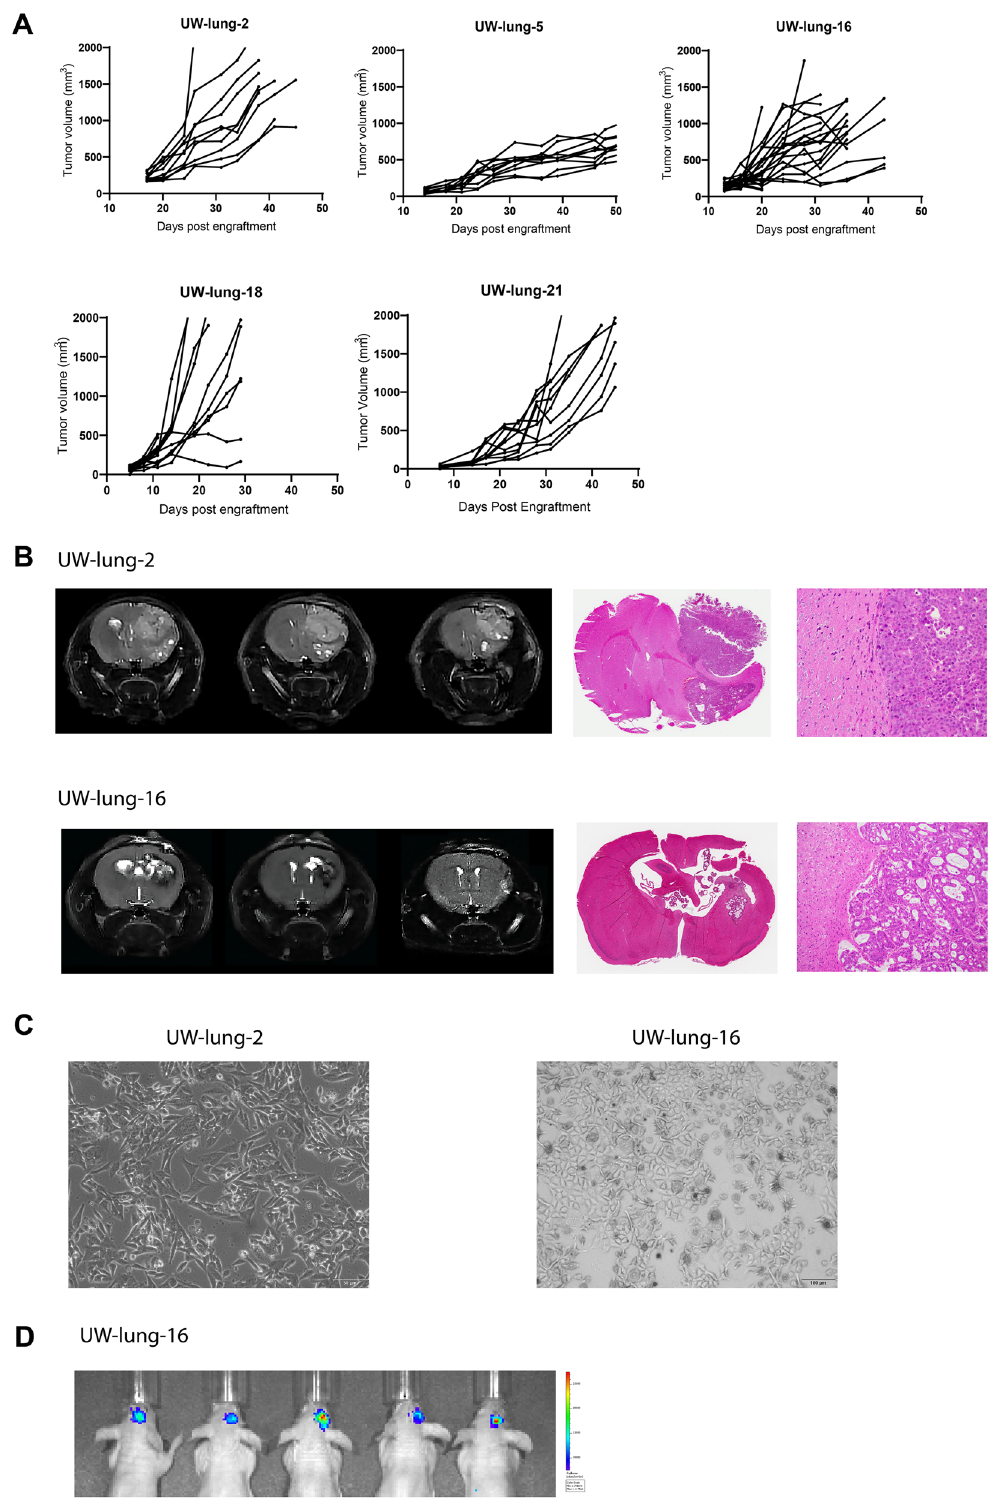
Figure 3. Establishment of subcutaneous flank and orthotopic intracranial patient non-small cell lung cancer (NSCLC) brain metastasis xenografts. ( A ) Subcutaneous flank xenograft growth characteristics of University of Wisconsin (UW)-lung-2, UW-lung-5, UW-lung-16 and UW-lung-18 and UW-lung-21. Tumors were derived directly from patients’ tumors. ( B ) Representative MR images and histology of UW-lung-2 and UW-lung-16 orthotopic intracranial xenografts. Tumors were first passaged subcutaneously and then directly implanted into the brain. They were not passaged in culture. ( C ) Pictures of established cell lines UW-lung-2 (passage 20) and UW-lung-16 (passage 20). ( D ) Representative images of UW-lung-16 luciferase-expressing cells grown as orthotopic intracranial